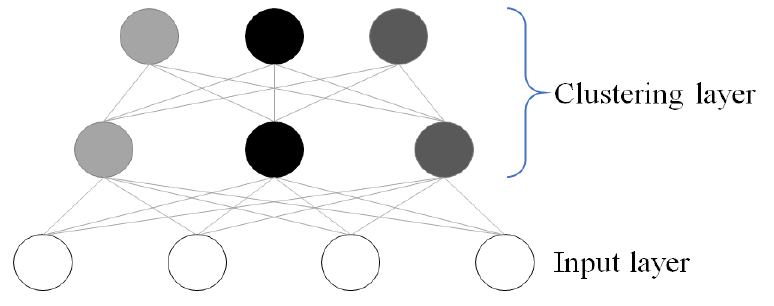
Figure 1. Double-layered learning structure.